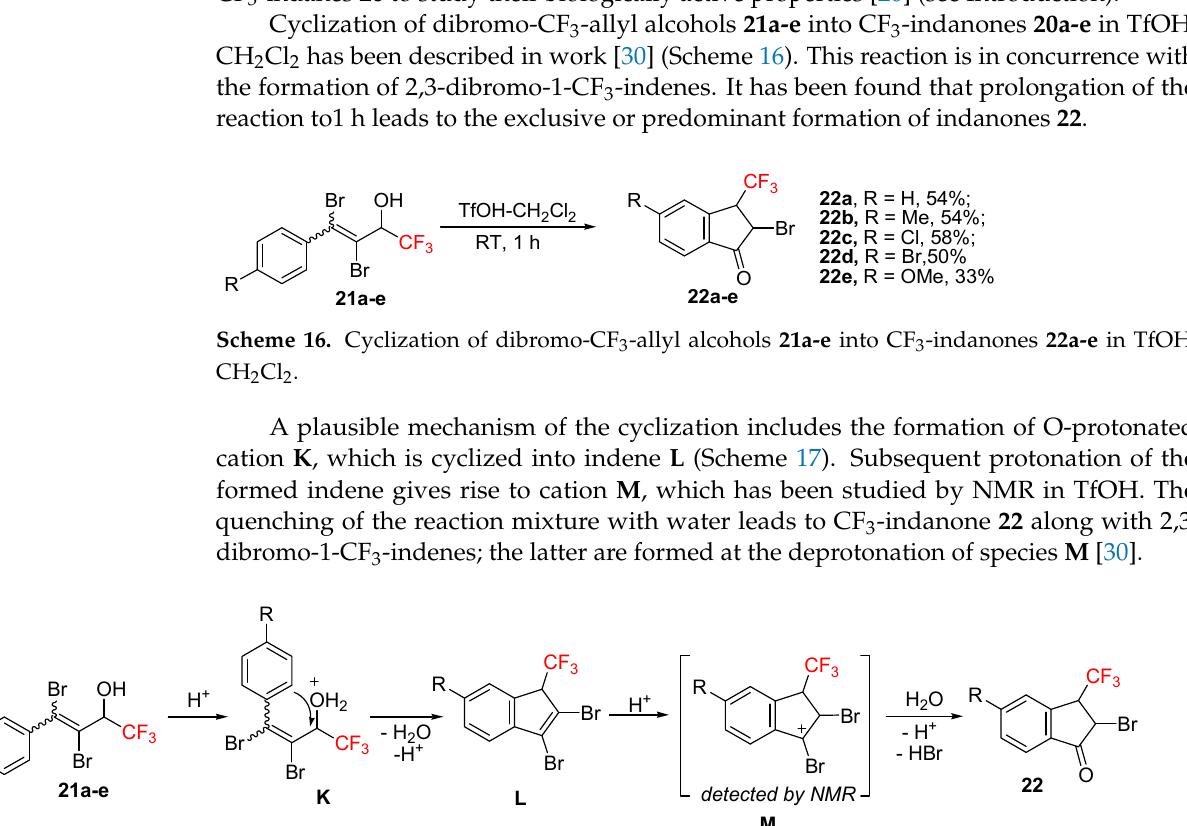
Scheme 15. TfOH-promoted synthesis of 1-CF 3 -indanes 20 from CF 3 -allyl alcohols 19 and arenes.